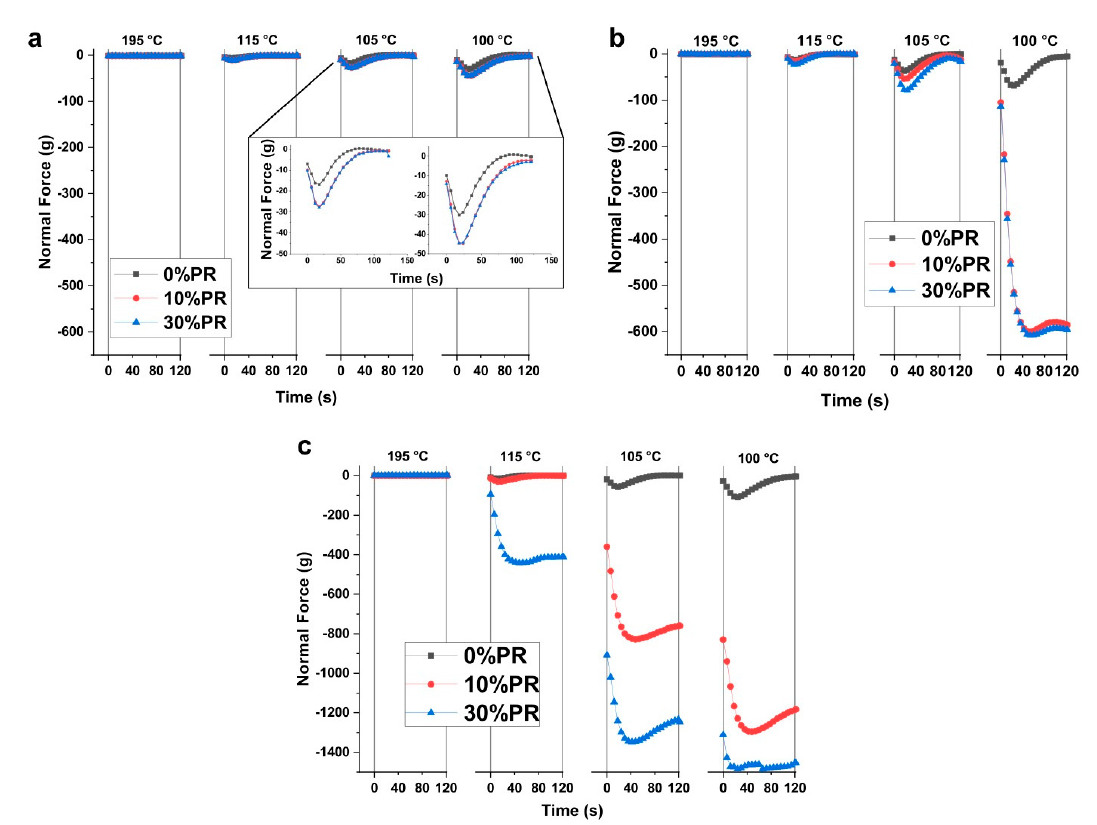
Figure 3. Normal force curves obtained with the constant gap test as a function of temperature and time for: PLA1/PPW ( a ), PLA2/PPW ( b ), and PLA3/PPW ( c ) composites.